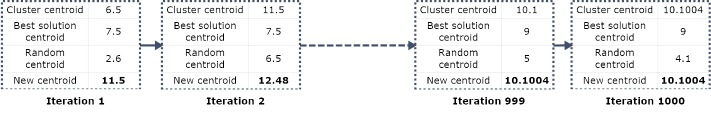
Example of the adaptive DE strategy performed on a cluster centroid of value 6.5 throughout 1000 iterations.